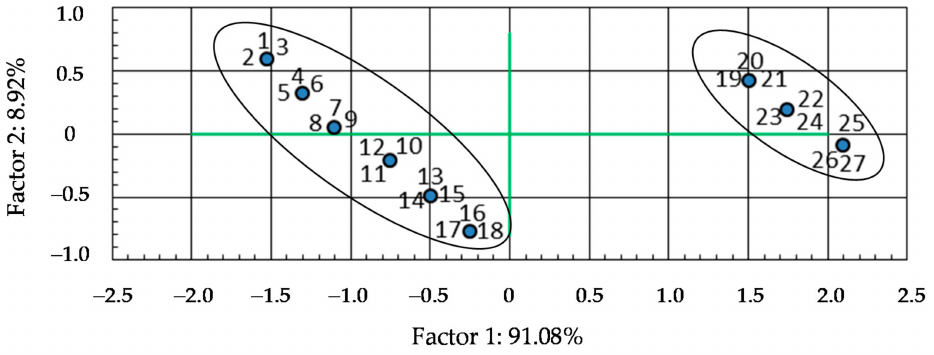
Figure 5. The spread of the mean arithmetic particle size of dust and the content of the finest particles. (1, 2, 3 are beech; 4, 5, 6 are oak; 7, 8, 9 are hornbeam; 10, 11, 12 are ash; 13, 14, 15 are alder; 16, 17, 18 are walnut; 19, 20, 21 are larch; 22, 23, 24 are pine; and 25, 26, 27 are spruce) based on the multiplicity factor of the mean arithmetic particle size of the dust created in sanding with sandpapers of grit sizes P60 and P180 and on the content of the finest particles. The clusters of results that form separate populations are marked in the loops.